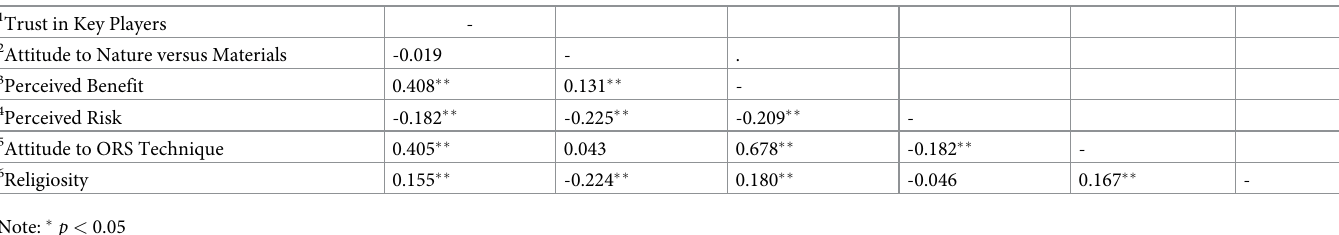
Table 1. The correlation matrix among the factors in the research (ORS